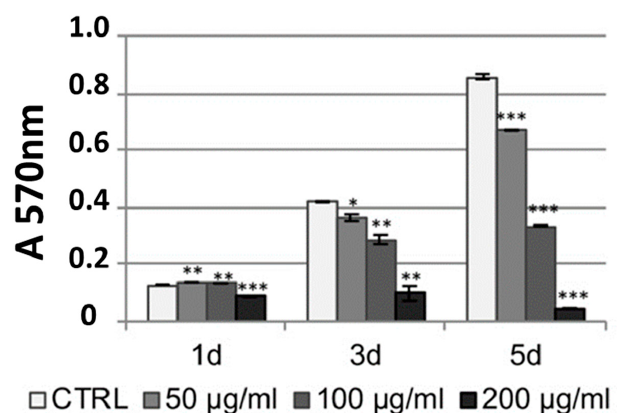
Figure 1. Adipose mesenchymal stem cells (ADSCs) viability measured by a methyl thiazolyl- tetrazolium (MTT) assay. Viability of control ADSCs and ADSCs treated with 50, 100 or 200 μ g/mL of Yunnan Baiyao (YB) at 1, 3 and 5 d of culturing in basal medium. * p < 0.05; ** p < 0.01; *** p < 0.001 vs. control